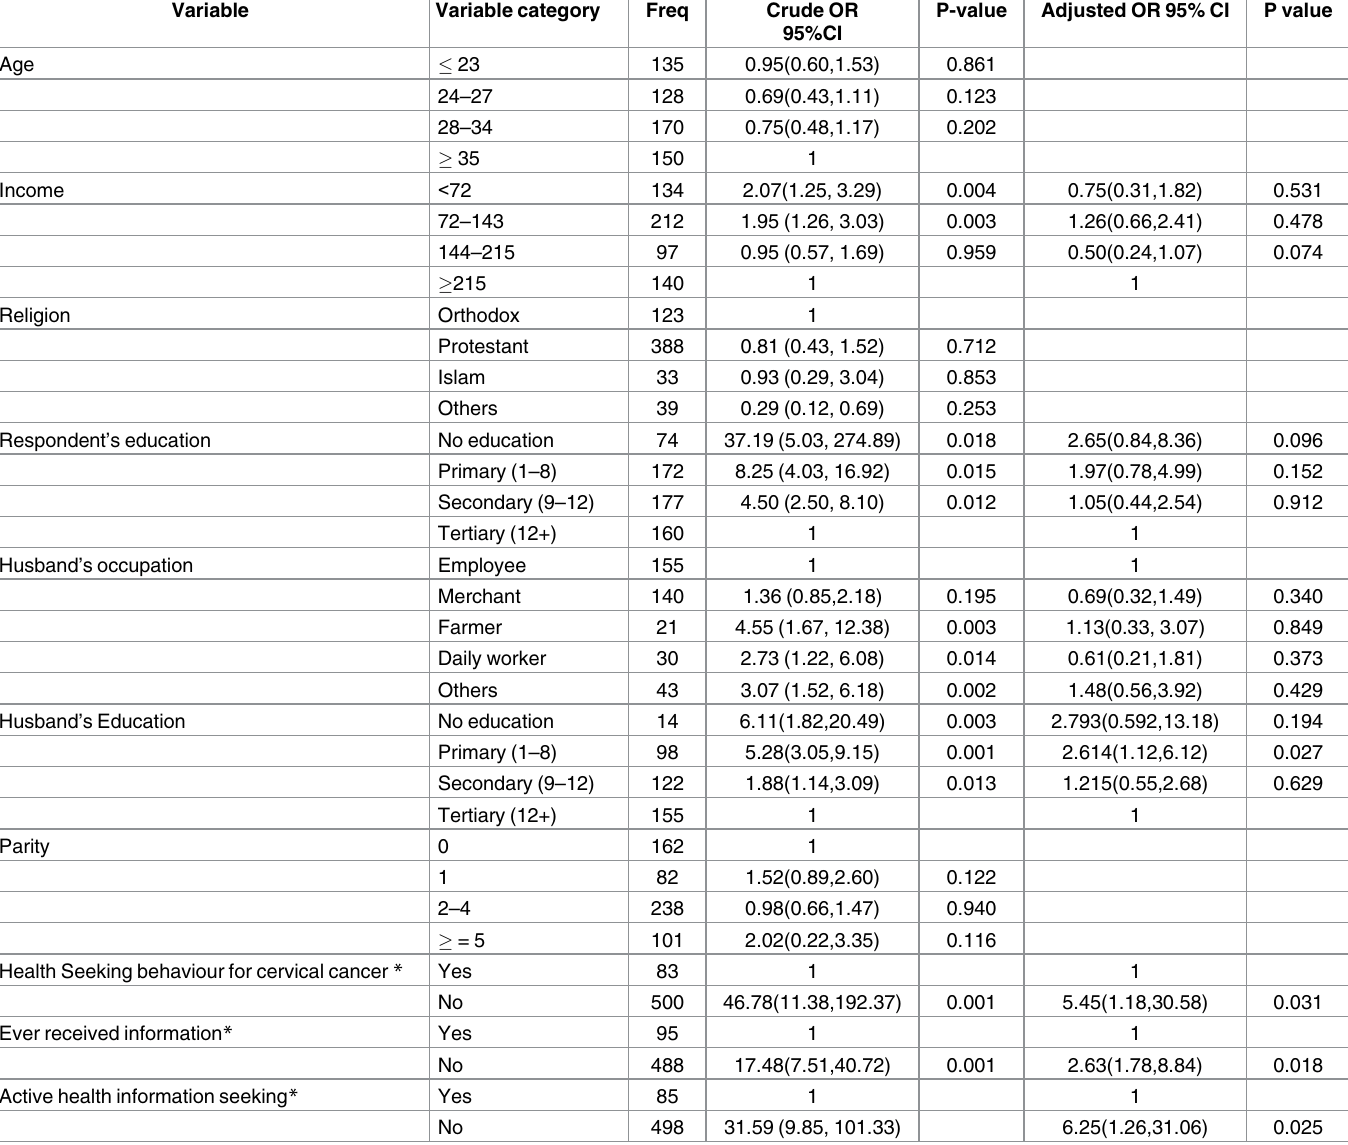
Table 4. Factors tested for association with cumulative knowledge score about cervicalcancer among the respondents in Hossana town Hadiya Zone, June, 2015.